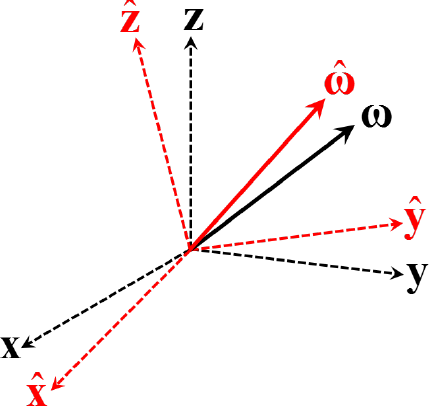
Figure 1. True and estimated (ˆ • ) attitude frames and angular